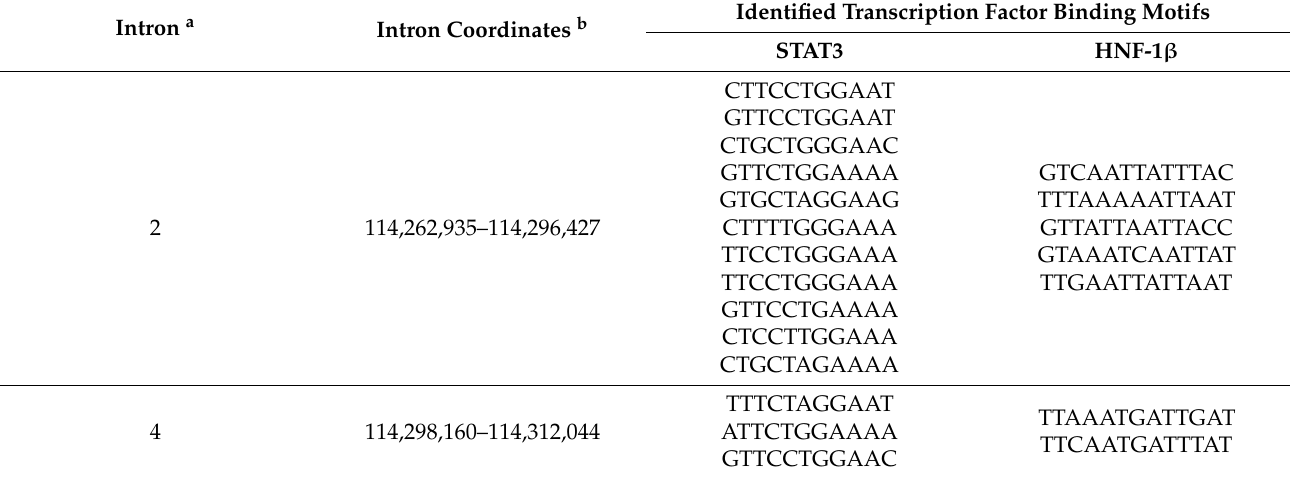
Table 1. Intronic STAT3 and HNF-1 β transcription factor binding sites in the NNMT gene. Identified Transcription Factor Binding Intron a Intron Coordinates b